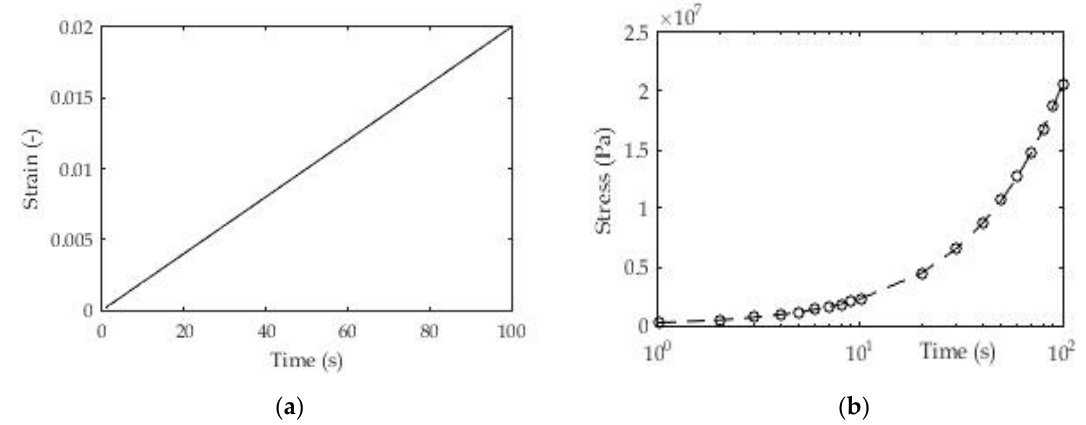
Figure 10. ( a ) Constant strain-rate test; ( b ) Experimental results for stress σ (t). Table 4. Prony series for ABS material and layer printing d = 0.19 mm.